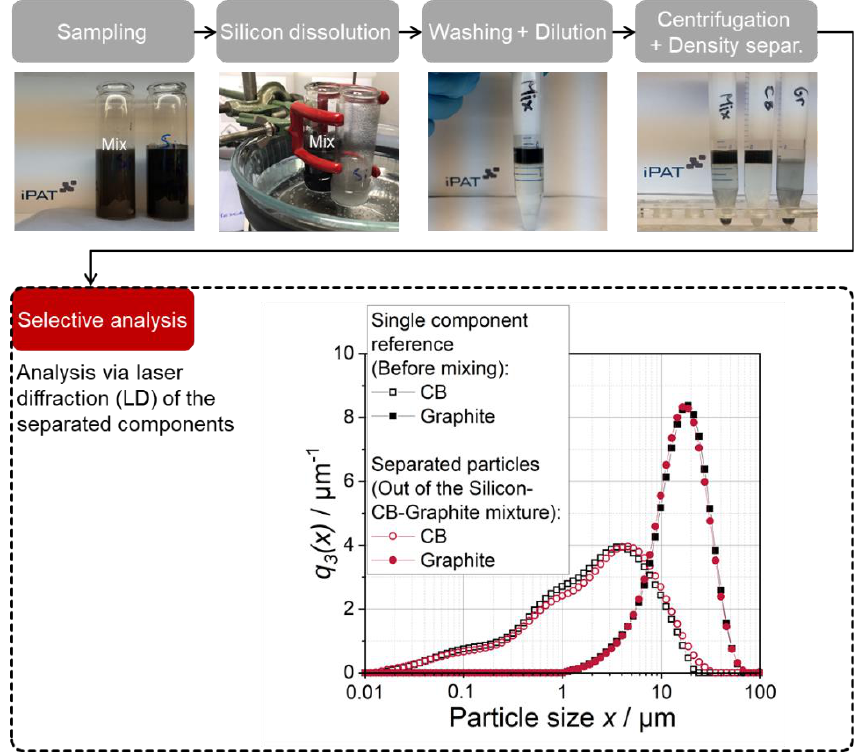
Figure 6. Scheme of the sample preparation to separate the carbon black (CB) and graphite particles from a silicon-CB-graphite mixture for a subsequent selective particle size analysis of both components by laser diffraction (LD).